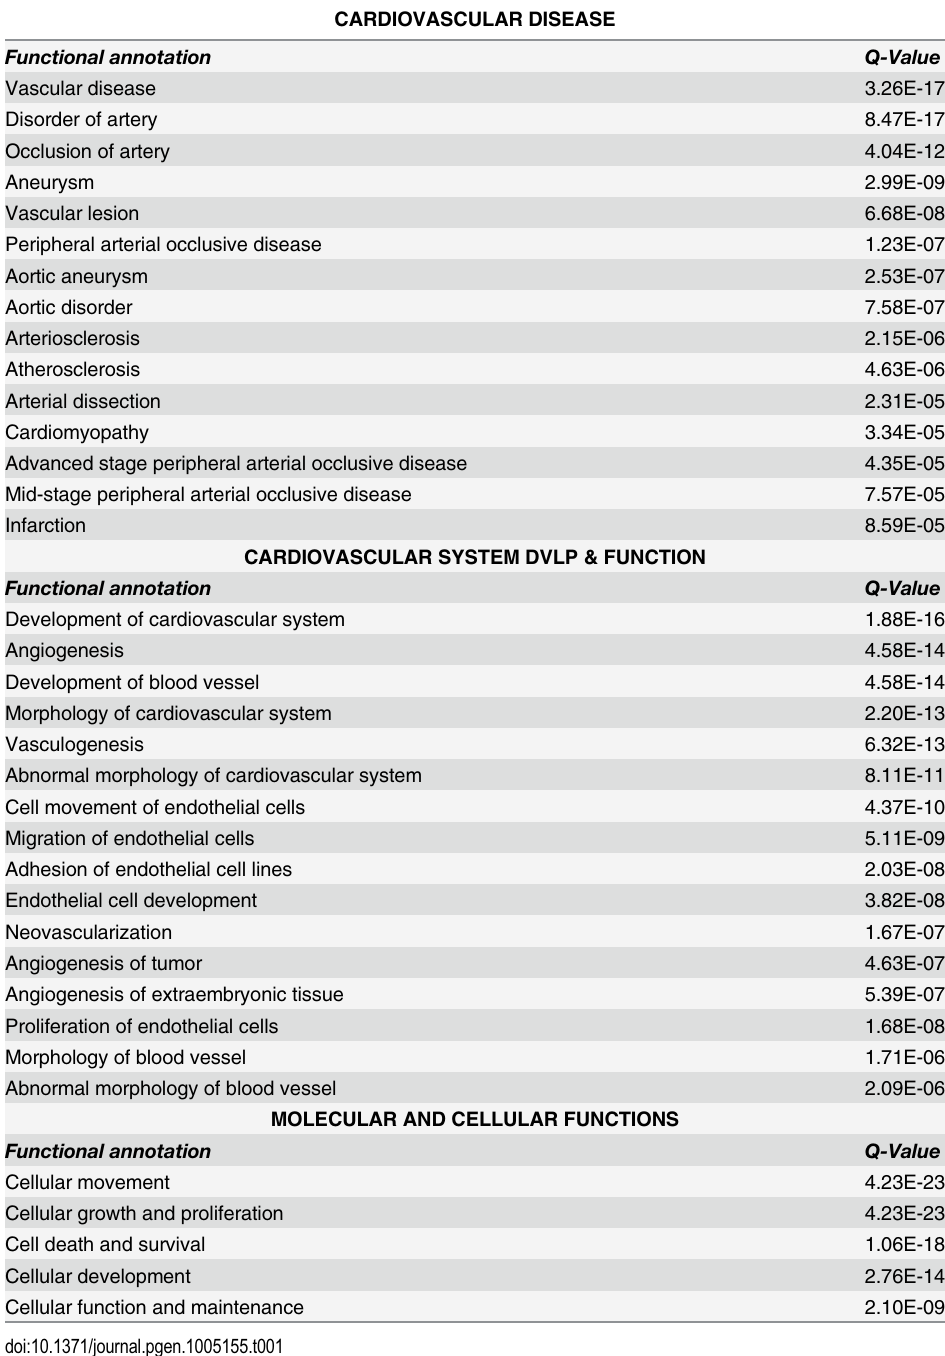
Table 1. Functional annotation derived from analysis of differentially expressed genes in si TCF21 RNA-Seq